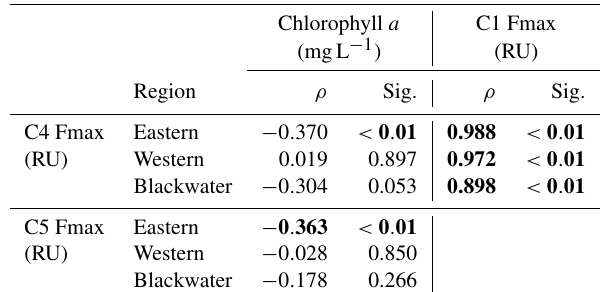
Table 2. Spearman rank correlations between PARAFAC compo- nents (C1, C4 and C5) and chlorophyll a concentrations in different